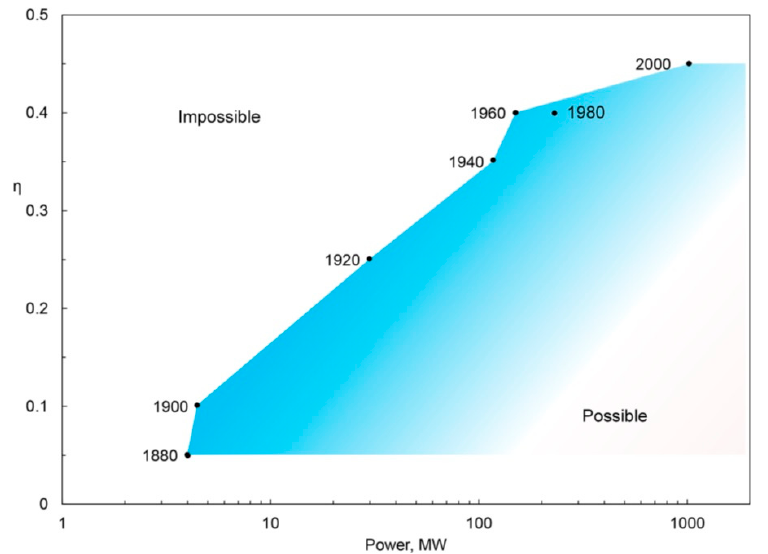
Figure 5. The evolution of design space of power plants, the crest of which is marked by the rising first-law efficiencies of the most efficient models [3].